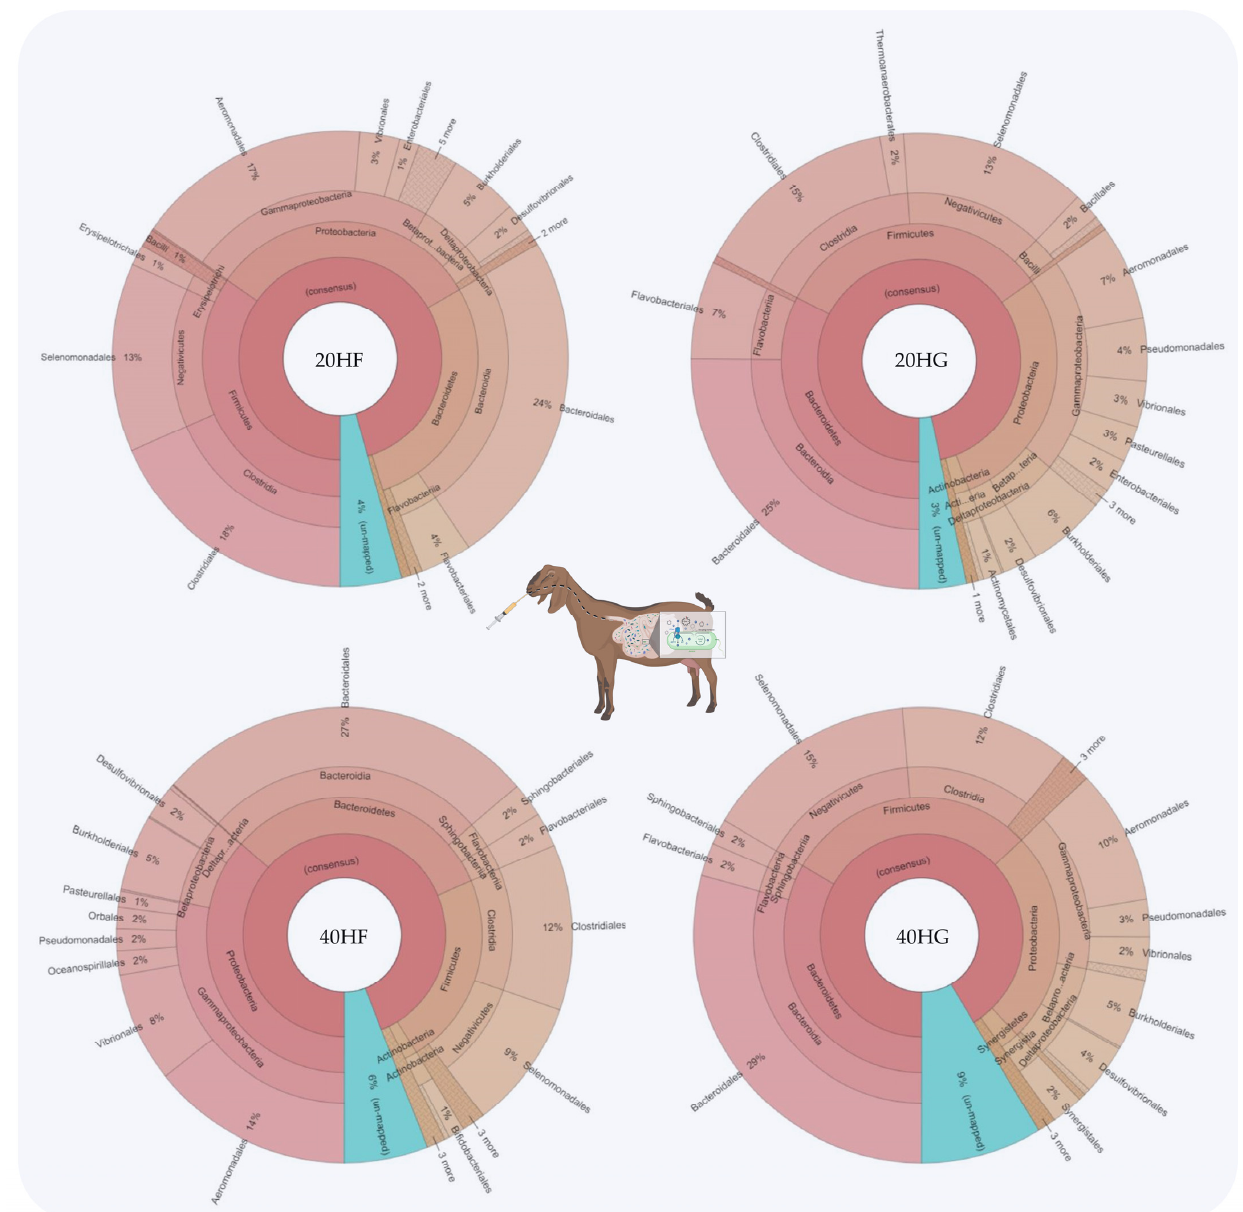
Figure 2. Relative abundance of the most abundant orders in the rumen fluid of goats fed diets (20HF, 20HG, 40HF, and 40HG) with different levels of Schizochytrium spp. (20 g and 40 g/goat/day) and two different forage to concentrate ratios (60:40 and 40:60) throughout the experimental period (21 and 42 experimental days) illustrated using Krona software. Additional statistics are available in Table S3.